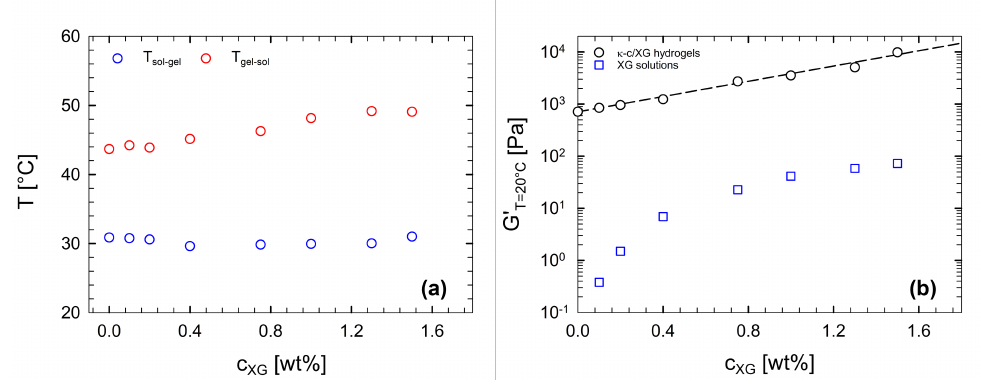
Figure 9. ( a ) T sol - gel (blue circles) and T sol - gel (red circles), evaluated at 1 ◦ C/min, as a function of the XG percentage concentration. The relative percentage content of κ -c is fixed at 1.5 wt% for each ternary solution. ( b ) G (cid:48) , evaluated at 20 ◦ C, as a function of the XG percentage in solution. Symbols are experimental data, and the dashed line is a nonlinear regression obtained via Equation (3). For each ternary solution (black circles), the relative percentage concentration of κ -c is fixed at 1.5